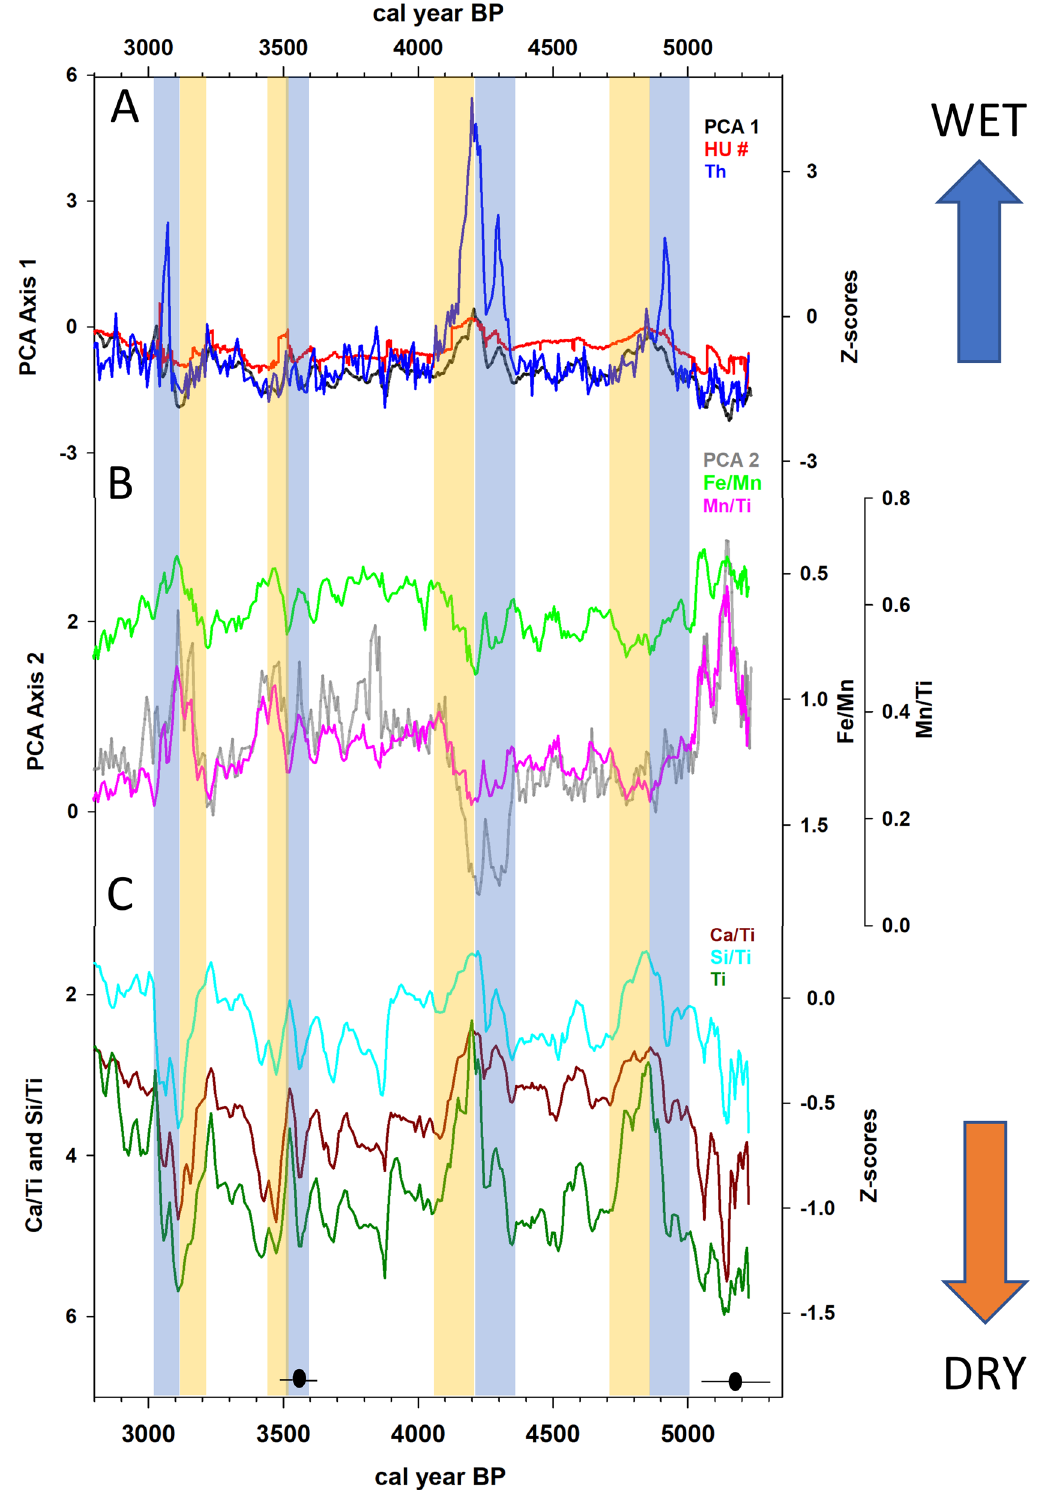
Figure 3. ( A ) Principal component analysis (PCA) Axis 1 (black), HU number (red), and Th (z-scores) (blue); ( B ) PCA Axis 2 (grey), Fe/Mn (reversed scale) (green) , and Mn/Ti (pink); ( C ) Ca/Ti (reversed scale) (red ochre), Si/Ti (reversed scale) (baby blue), and Ti (z-scores) (dark green). The vertical tan and blue-shaded boxes represent intervals characterized by negative and positive hydroclimate anomalies, respectively. The mean value (black circle) and 2-sigma range (black line) for the calibrated ages, based on the radiocarbon dates available for this portion of the core, are also